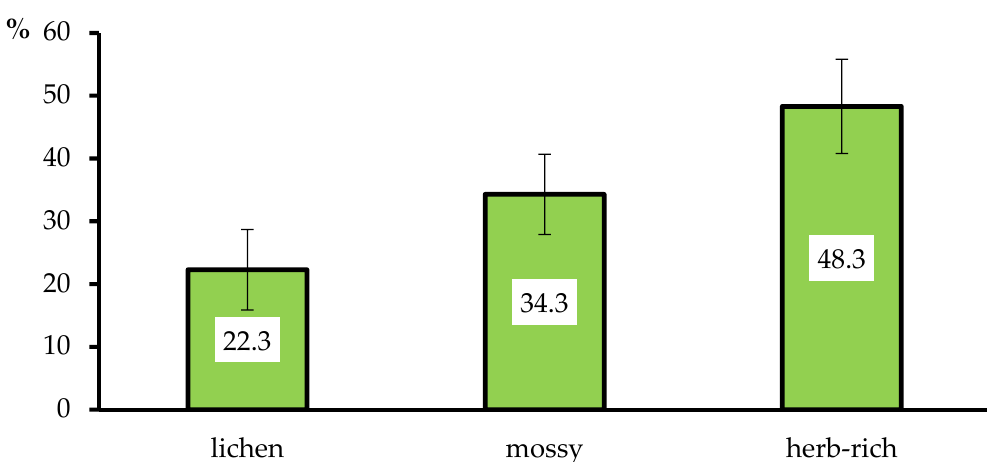
Figure 2. Weighted average (by age) prevalence (P) of red ring rot in different forest types. Data are the mean values ± standard error.